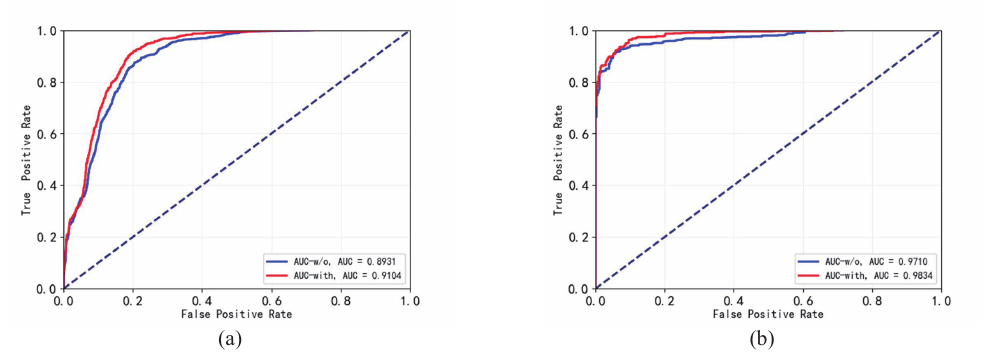
Figure 7. The ROC/AUC curves of the GE detectors trained with and without utilizing the FTS loss on multiple datasets. The red curve represents the detector trained with FTS loss. The blue curve represents the detector trained without FTS loss. ( a ) The ROC/AUC curves on Avenue dataset. ( b ) The ROC/AUC curves on Ped2 dataset. The dashed blue line represent the ROC curve of a completely random classifier. Table 2. Frame-level GE saliency and ROC/AUCs of the GE detectors on multiple datasets. The bold font represent GE saliency of anomalous frames and ROC/AUC performances utilizing the FTS loss. FTS Loss Ped1 Ped2 Avenue SH GE saliency of